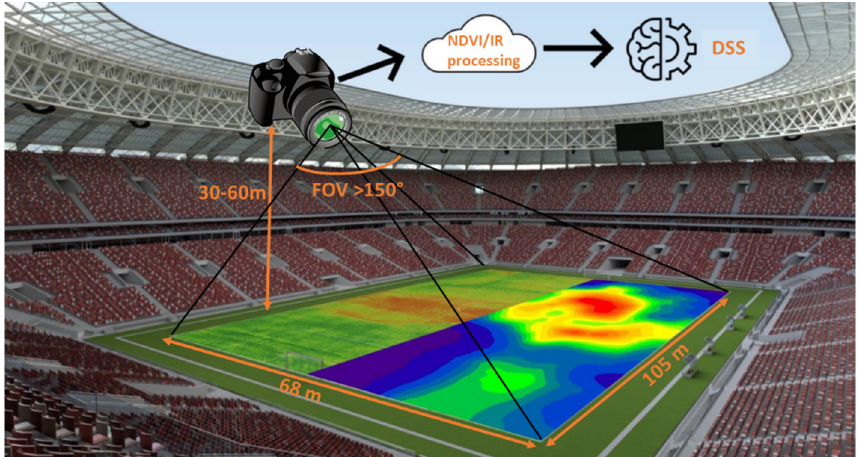
Figure 1. Targeted novel camera design, using fixed camera positioning while observing the whole field thanks to the wide field of view. The multichannel camera design enables the calculation of the vegetational indices, providing input to a decision-support system (DSS).